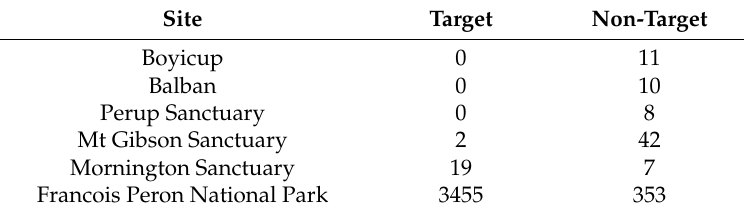
Table 4. Total number of cats (target) and by-catch (non-target) trapped at each site.